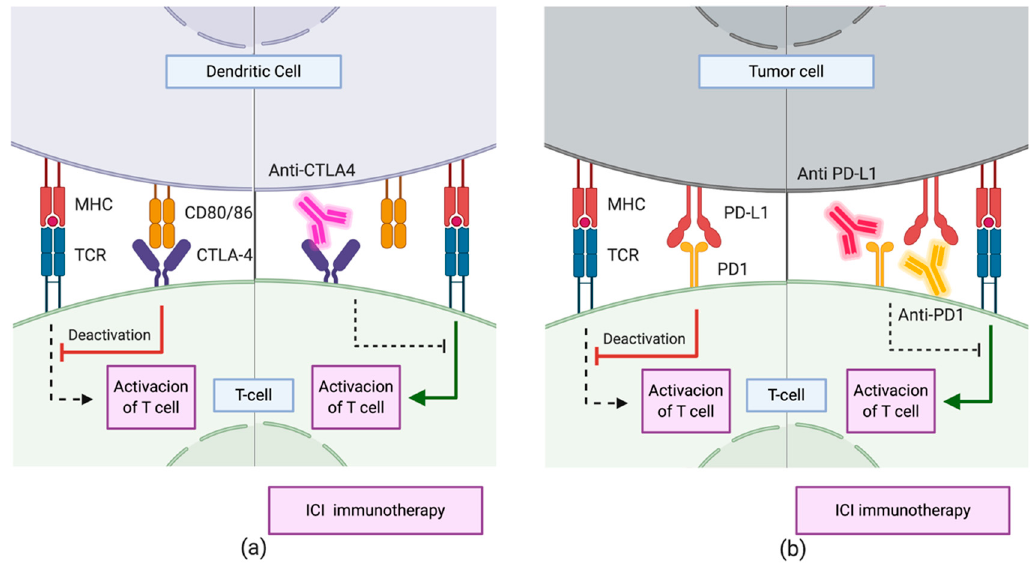
Figure 6. Immune checkpoint inhibitor immunotherapy through mechanisms involving ( a ) CTLA-4 and ( b ) PD1 / PD-L1. During the priming phase, T cell activation requires two complementary signals: the engagement of the MHC complex to the T cell receptor (TCR) and the absence of interaction between CTLA-4 and CD80 / 86. Conversely, T cell activation will be strongly suppressed. Similarly, during the e ff ector phase, the absence of interaction between PD1 and PD-L1 upregulates T cell